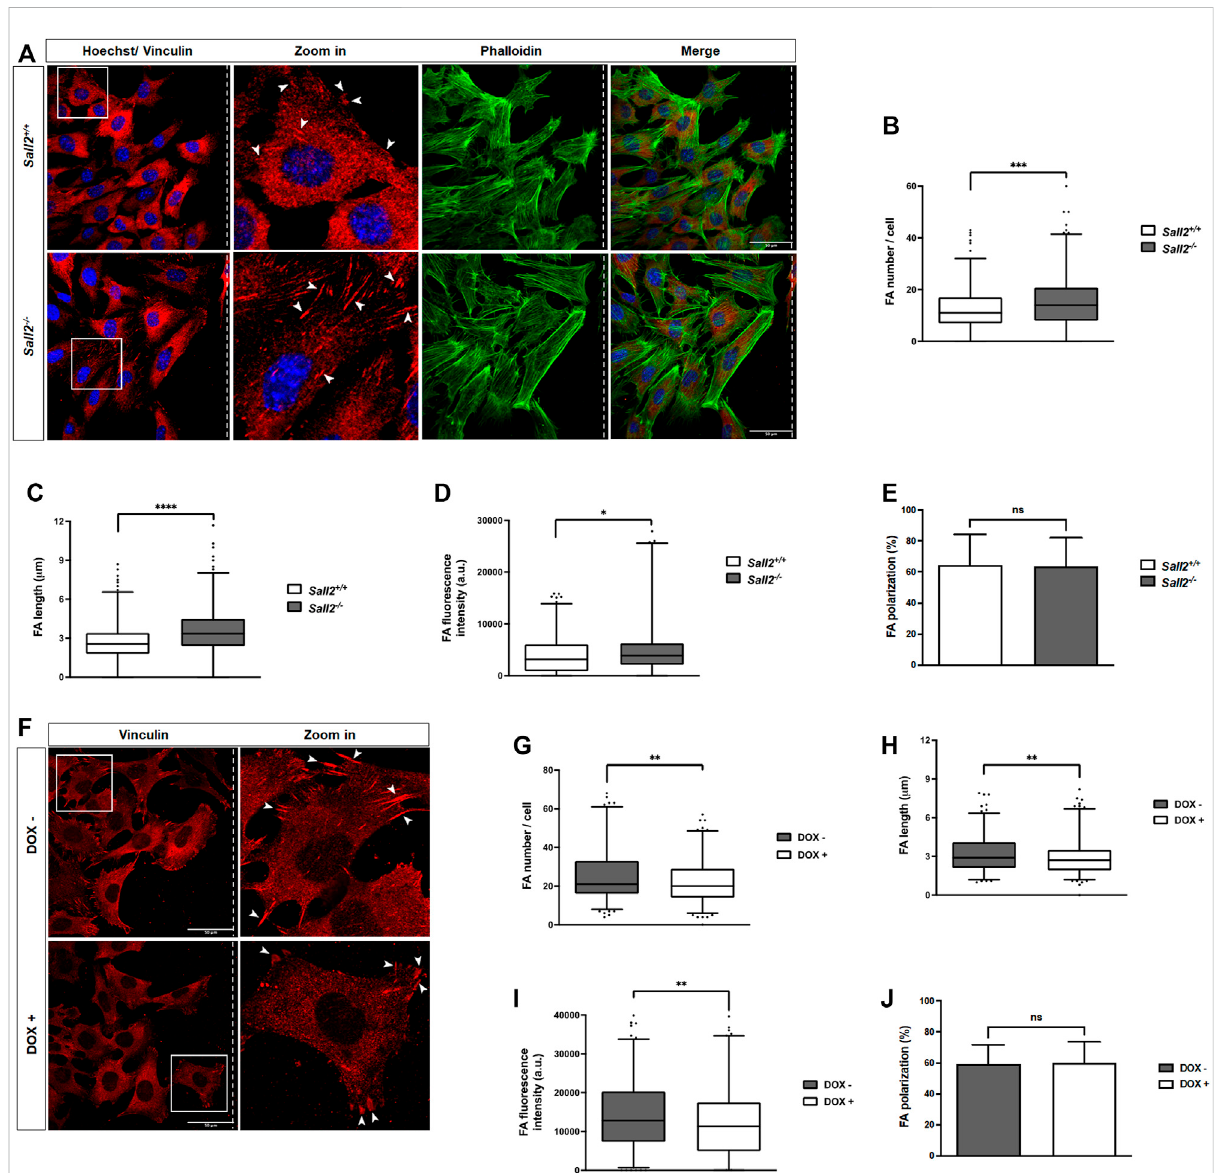
FIGURE 3 Sall2decreases focaladhesionsmaturation. (A) Representative confocal images from Sall2 +/+ and Sall2 − / − iMEFs aftercell migrationinductionat 16 h(40x). Cellswere fi xed,and FAswerestainedwith anti-vinculin antibody (red),phalloidinstained F-actin (green), andHoechststained thenuclei (blue).Dashedlinesindicatethepositionofthewound,andthearrowheadsshowFA. (B – E) Quanti fi cationofFAnumberpercell (B) ,FAlength (C) ,FA fl uorescence intensity (D) , and FA polarization (E) from Sall2 +/+ and Sall2 − / − cells. (F) Representative confocal images from the Sall2 Tet-On iMEFs inducible model after cell migration induction at 16 h (40x). (G – J) Quanti fi cation of FA number per cell (G) , FA length (H) , FA fl uorescence intensity (I) , and FA polarization (J) from the Tet-On Sall2 iMEFs. For each experiment at least 100 cells were analyzed per genotype. Data are shown as a box-and-whiskers plot from three independent experiments. The whiskers represent the 2.5th and 97.5th percentile, the box extends from the 25th to the 75th percentile, and the line indicates the median. (n.s, not signi fi cant, * p = 0.01 to 0.05, ** p = 0.001 to 0.01, *** p = 0.0001 to 0.001, **** p ≤ 0.0001; unpaired t